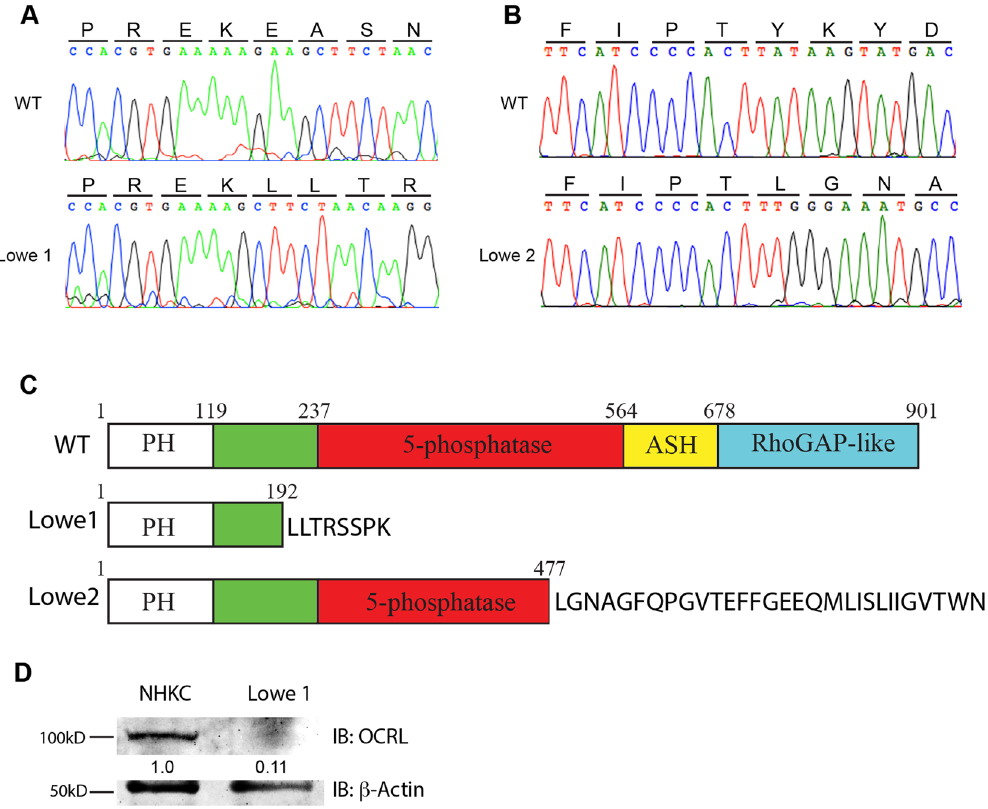
mutation of gene OCRL (c.739-742delAAAG, p. Lys192Lys fsX8) in exon 8. ( B ) DNA sequencing of the OCRL gene in keratinocytes from Lowe patient 2 revealed a novel 37-basepair deletion mutation at the tail of exon 14 of OCRL (c. 1595-1631del, p. Tyr477Leu fsX). ( C ) The 4-basepair deletion at exon 8 in Lowe patient 1 caused a reading frame shift with 8 unpredicted amino acids at amino acid 192 in the region between PH and